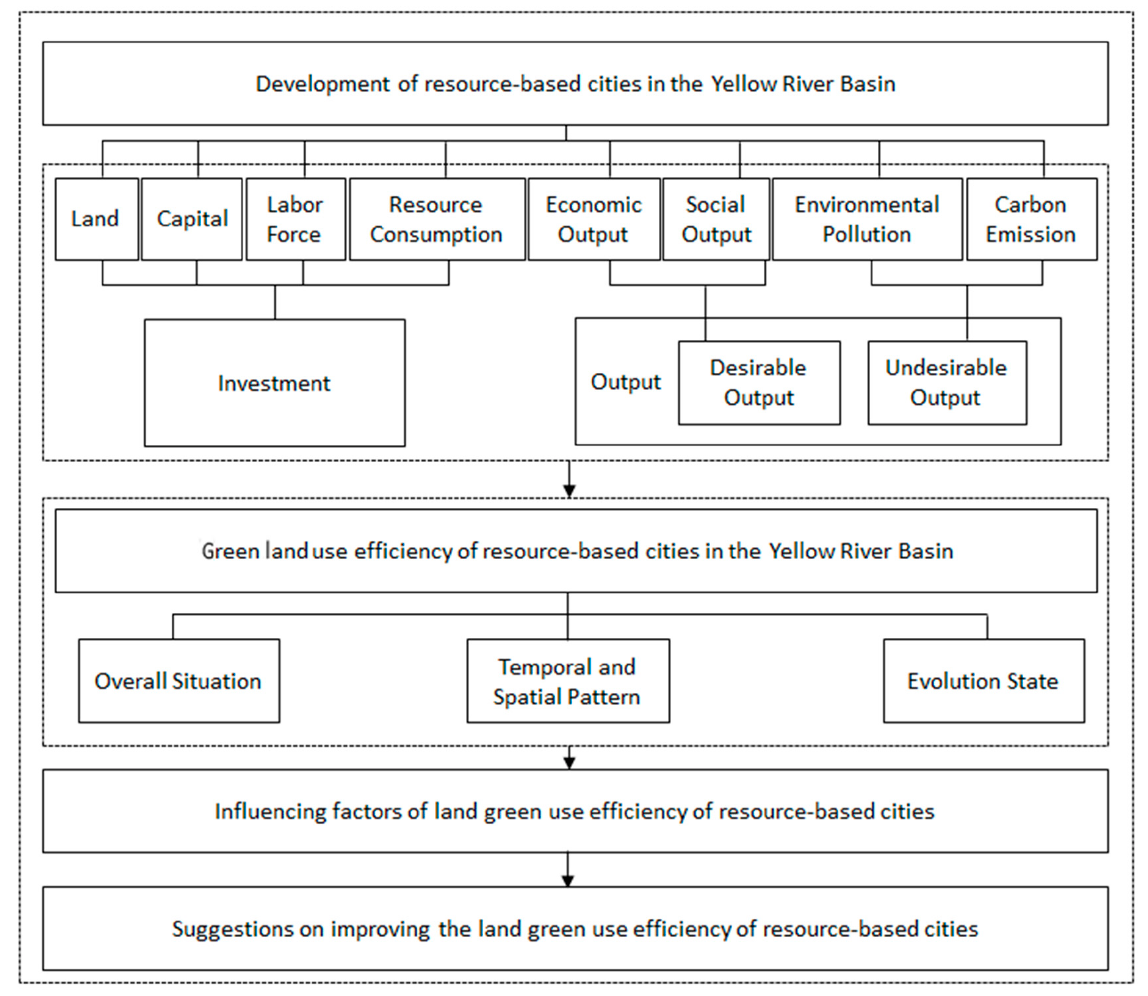
Figure 2. Research technology methodology.